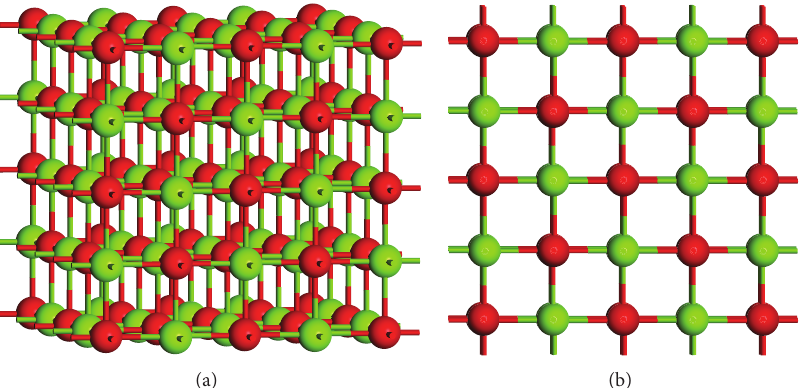
Figure 1: Lateral (a) and top (b) views of the slab used for all calculations. Oxygen atoms in red balls and metal atoms in green